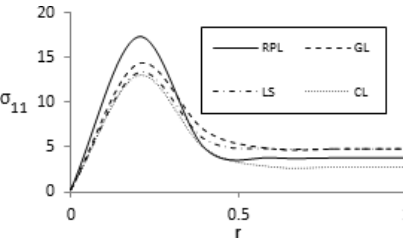
Figure 3: Distribution of radial stress with the radius via-RPL ℜ = 1